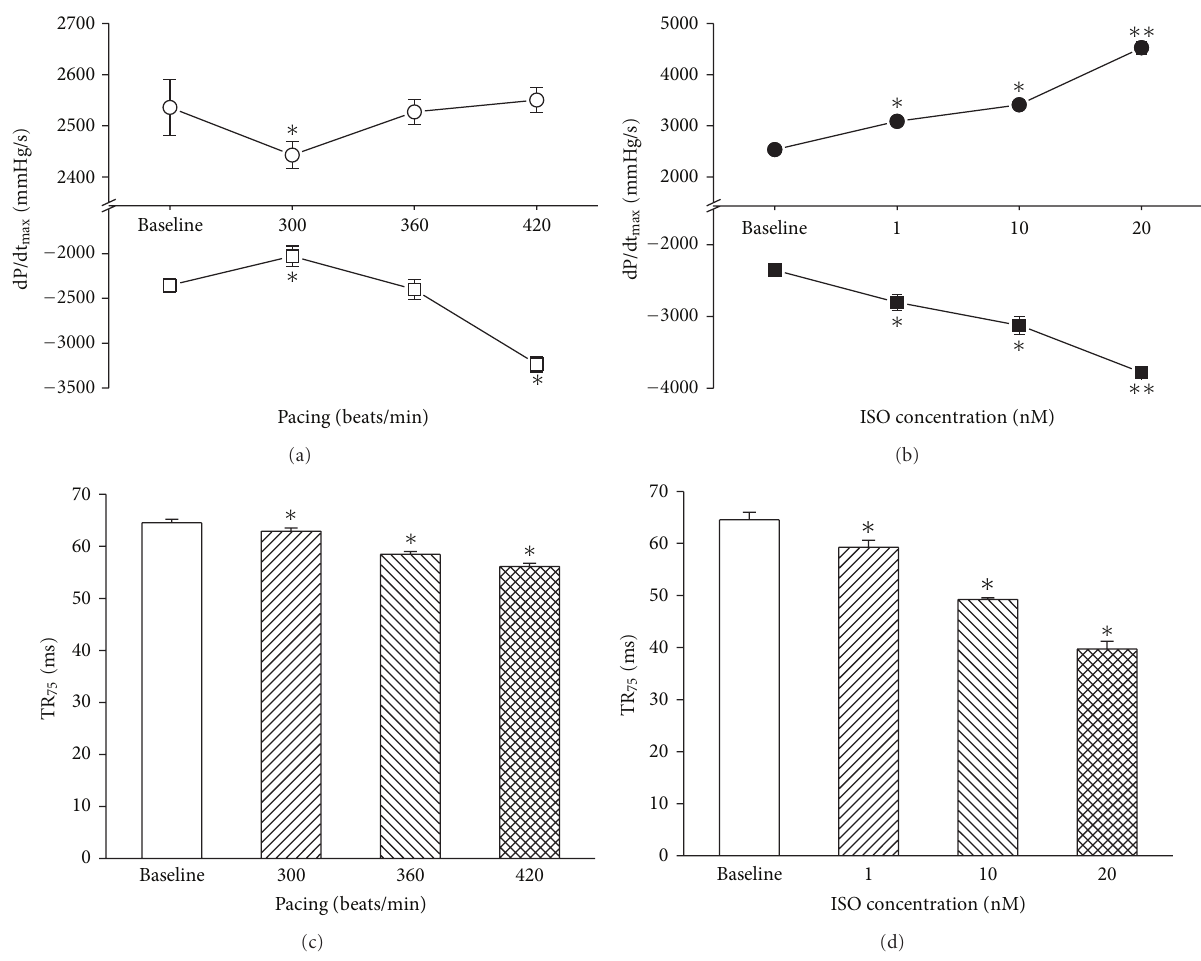
Figure 3: Maximal rates of left ventricular pressure development and relaxation ( ± dP/dt max ) and time from peak to 75% relaxation (TR 75 ) of left ventricular pressure. (a) and (c) ± dP/dt max and TR 75 under di ff erent rates of pacing. (b) and (d) ± dP/dt max and TR 75 in di ff erent concentrations of ISO treatment. Data are mean ± SEM, n = 6 hearts for each ISO concentration in each group. ∗ P < 0 . 05 or ∗∗ P < 0 . 01 versus